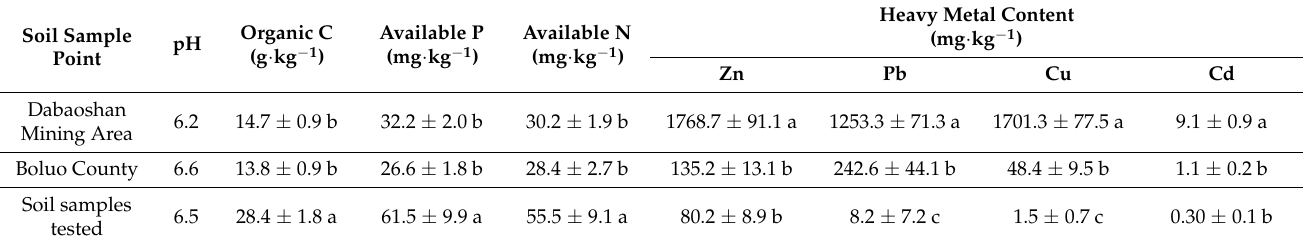
Table 1. The basic chemical properties of the soil at the sampling points of two ecotypes of M. floridulus and the soil for the pot experiment